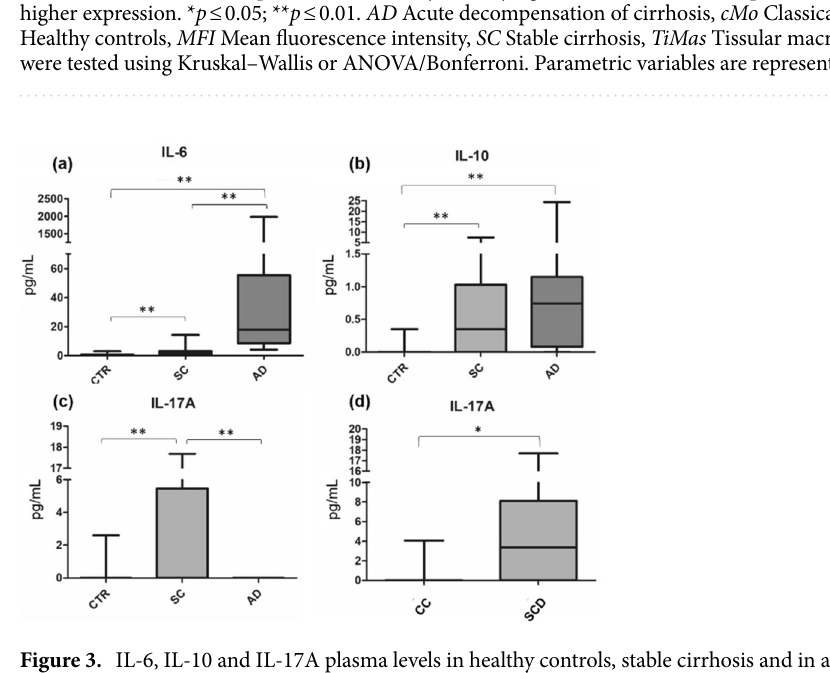
Supplementary material). The results demonstrated that patients with more advanced disease have higher cMo frequencies, lower TiMas frequencies, and lower DC frequencies. A moderate positive correlation was found between TiMas/cMo HLA-DR ratio and MELD score. Regarding the DC compartment, high pDC frequency and pDC/cDC ratio correlated moderately and positively with Child–Pugh score. IL-6 correlated positively with MELD and Child–Pugh scores, whereas IL-17A correlated negatively with the scores. MELD scores were categorized into three groups (≤ 9, 10–19, and ≥ 20) and Child–Pugh scores into three classes (A, B, and C). Patients with advanced liver disease showed altered distribution of monocyte subsets, lower HLA-DR expression on cMo, lower DC frequencies, and higher pDC proportion within the DC compartment